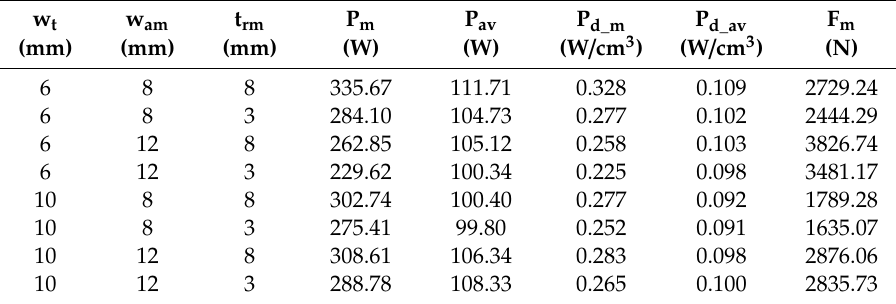
Table 3. Factors and machine’s performance.